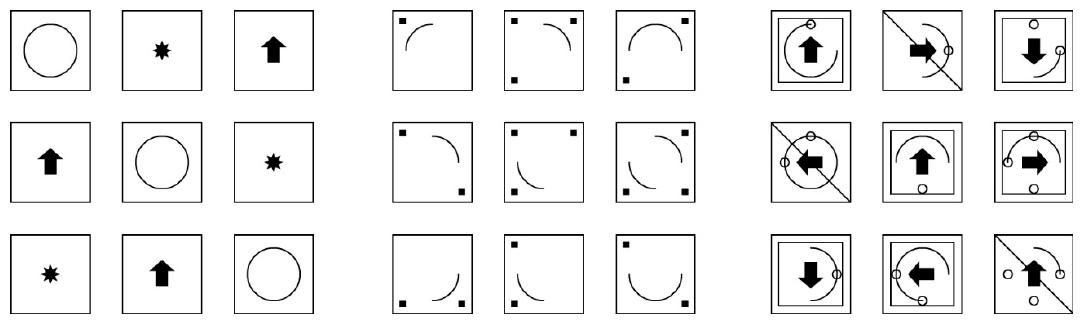
Figure 7. Items 3, 18, 32 (correct response shown for clarity).